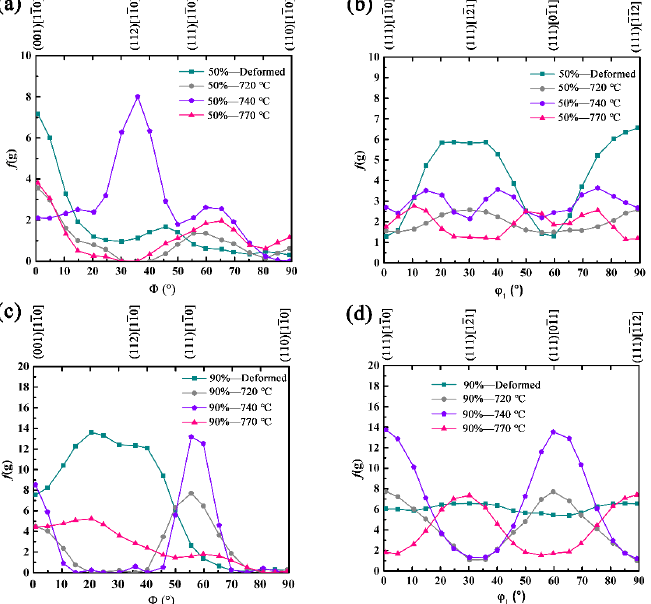
Figure 9. Orientation densities along ( a , c ) α -fiber and ( b , d ) γ -fiber in the cold-rolled sheets after annealing at different temperatures with ( a , b ) 50% reduction and ( c , d ) 90% reduction,